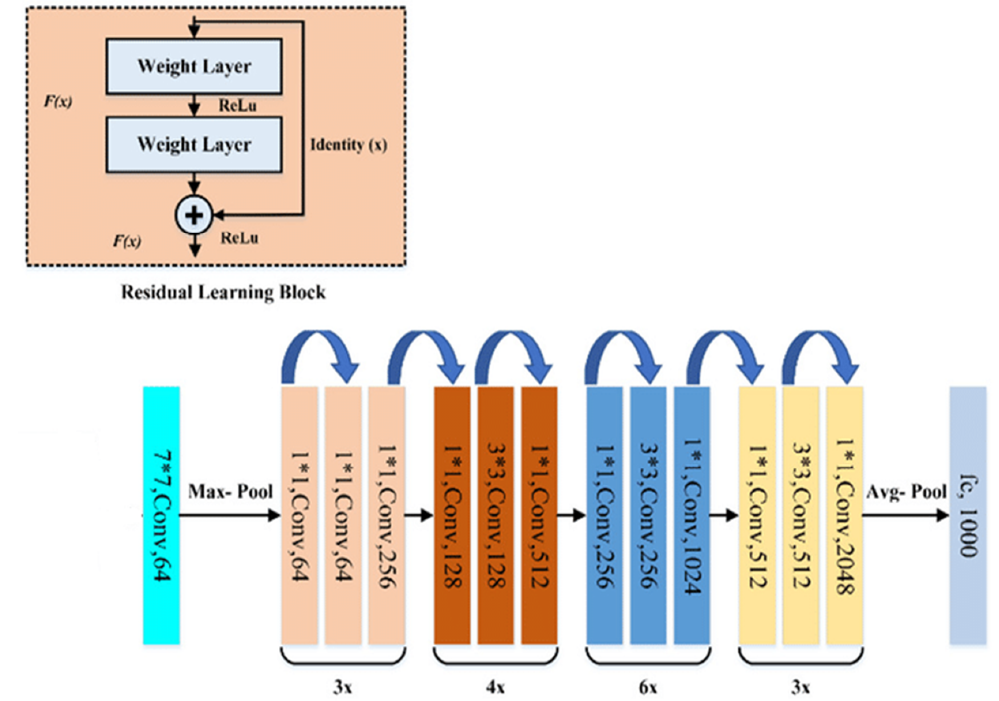
Figure 2. Illustration of a ResNet50 architecture or